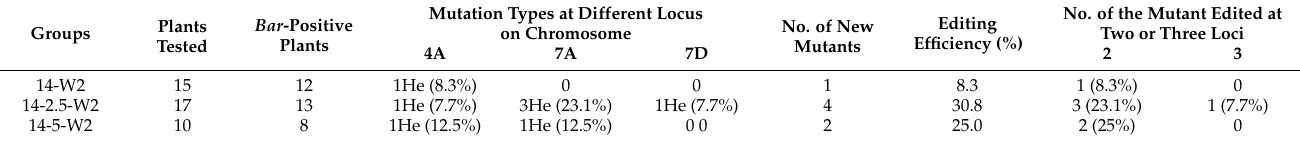
Table 3. The editing efficiency of TaWaxy genes with new mutations after nicotinamide treatment on immature embryos of transgenic plants which carry genome editing vectors (hemizygous) and with single chromosome